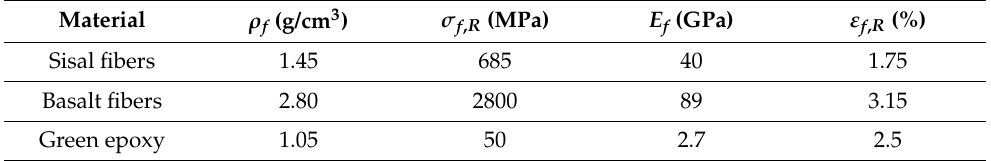
Table 1. Mechanical properties of materials used for sisal and basalt/sisal biocomposites.